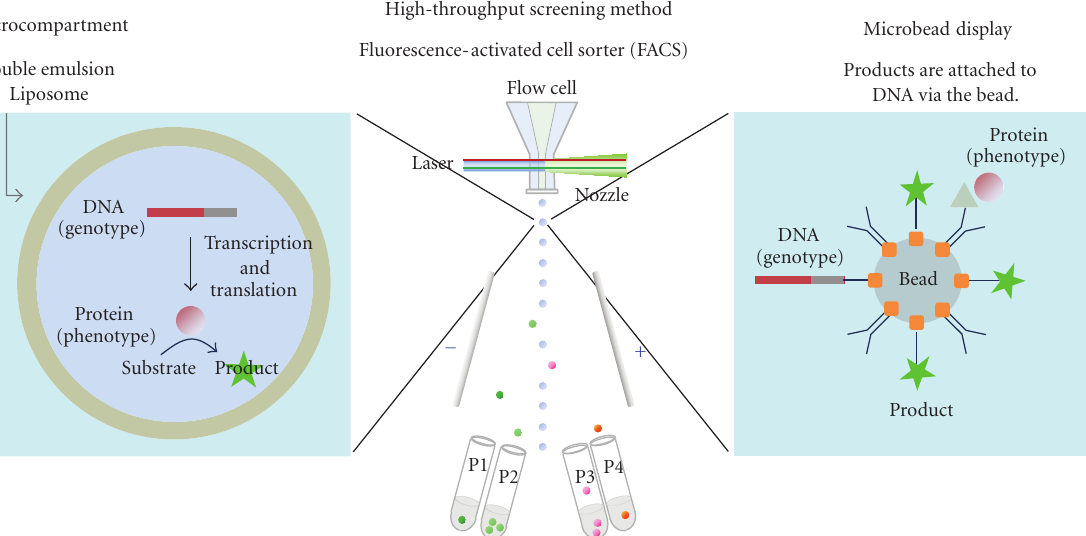
Figure 2: The underlying concept for in vitro compartmentalization (IVC) using double emulsion or liposome (left) and microbead (right). In both cases, a fluorescence-activated cell sorter (FACS) (center) is used for high throughput